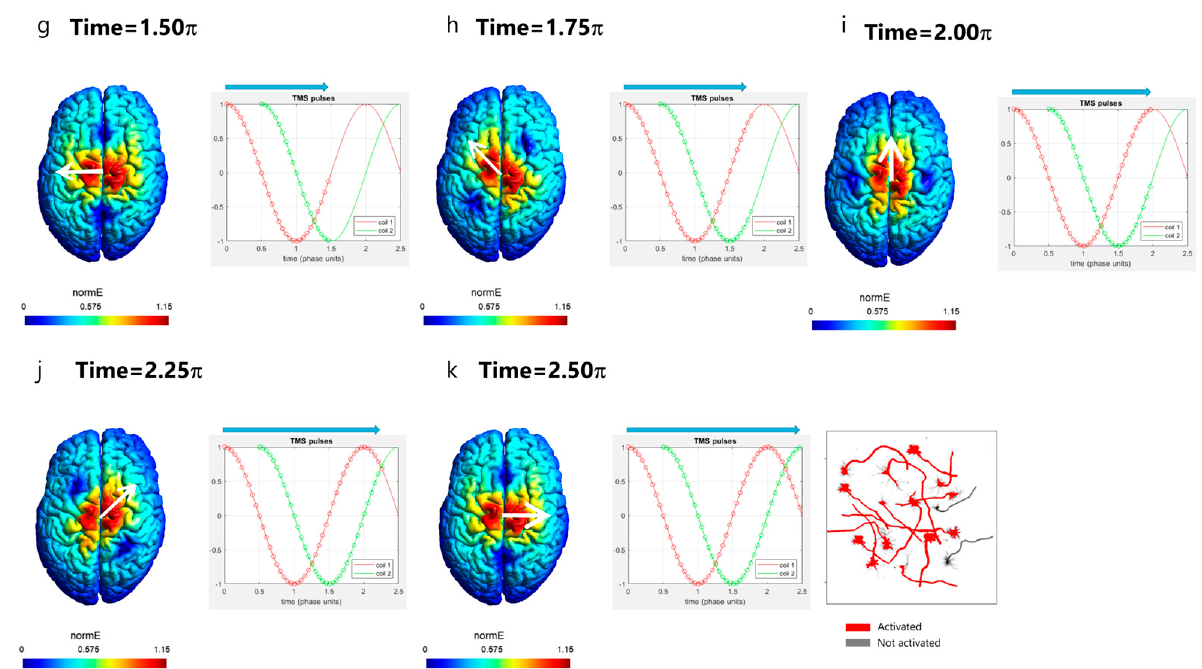
Figure 4. rfTMS scheme: Operation of two orthogonal coils with a lag of ¼ cycle. Shown the evolution of the electric field direction during the pulse in an rfTMS operation. ( a – k ) electric field orientation and amplitude at specific timepoints during the pulse, from time = 0 to time = 2.50 π . k. With the rfTMS scheme after completion of the coils’ pulses, neurons in many orientations are activated (indicated in red).